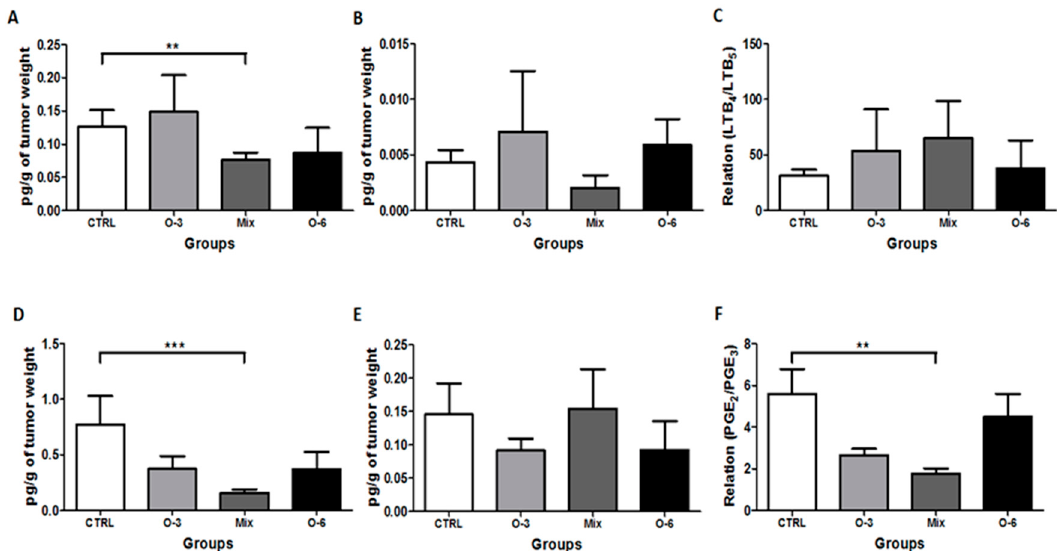
Figure 3. Determination of inflammatory mediators. C57BL/6 mice were coinjected with 10 6 B16F10 apoptotic cells plus a sub-tumorigenic dose of 10 3 B16F10 viable melanoma cells in a subcutaneous tissue. After the coinjection, the mice were treated by gavage during five consecutive days with fish oil rich in omega-3 or soybean oil rich in omega-6 or a mixture of these oils in a ratio of 1:1. After 21 days, the tumors were removed and a homogenate was obtained to evaluate the concentration of LTB 4 ( A ), LTB 5 ( B ), the ratio between LTB 4 and LTB 5 (LTB 4 /LTB 5 ) ( C ), prostaglandin E 2 (PGE 2 ) ( D ), prostaglandin E 3 (PGE 3 ) ( E ), and the ratio between PGE 2 and PGE 3 (PGE 2 /PGE 3 ) ( F ) in the tumor microenvironment. All experiments were carried out using groups of five 6–8 week old female mice in, at least, two independent experiments. The risk value α was set at 5% ( p < 0.05). ** p < 0.01, *** p < 0.001.